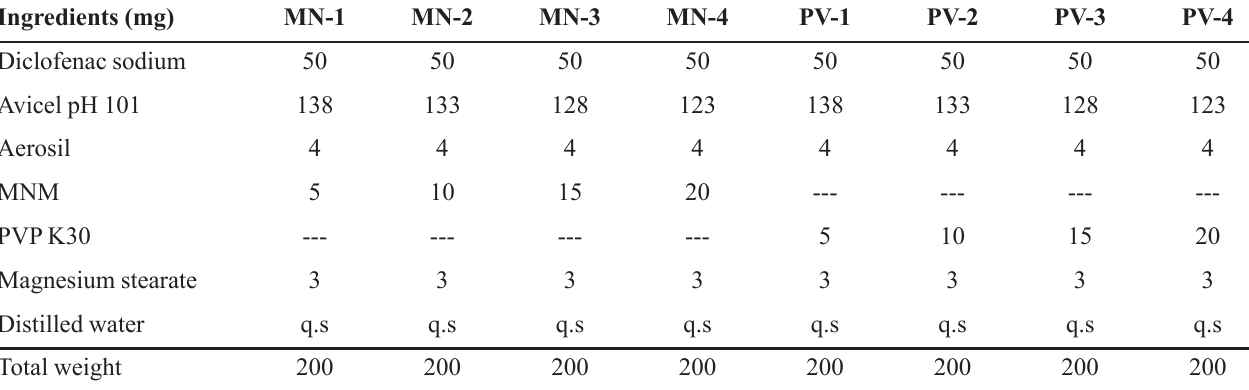
Magnesium stearate Distilled water